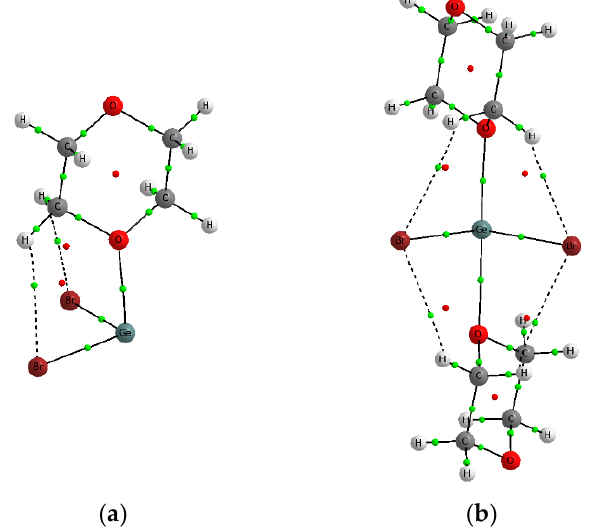
Figure 6. The molecular graphs of ( a ) GeBr 2 -C 4 H 8 O 2 and ( b ) GeBr 2 -(C 4 H 8 O 2 ) 2 ; big circles correspond to the attractors (red — oxygen, brown — bromine, grey — germanium, white — hydrogen), small green circles to the bond critical points and red circles to the ring critical points; solid and broken lines indicate bond paths.